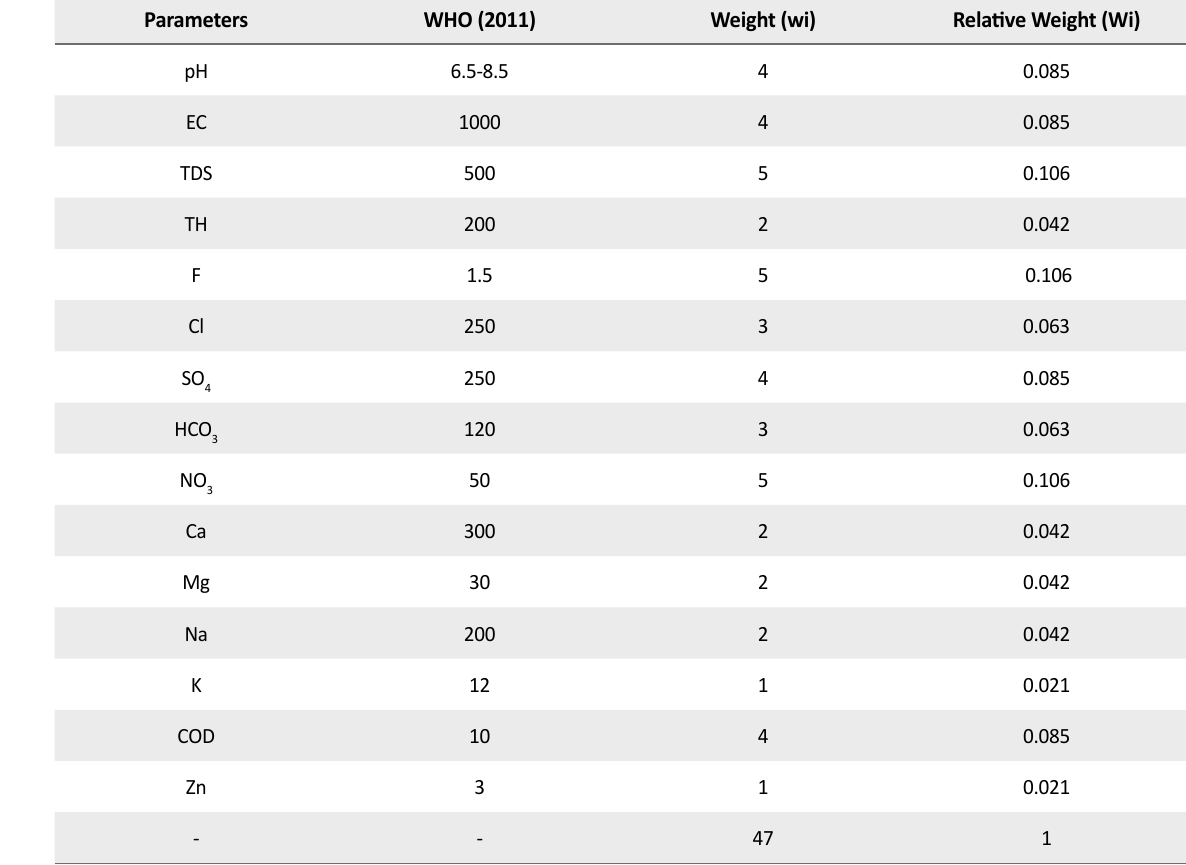
Table 2. Descriptive Statistics of parameters and the values used for Water Quality Index (WQI)